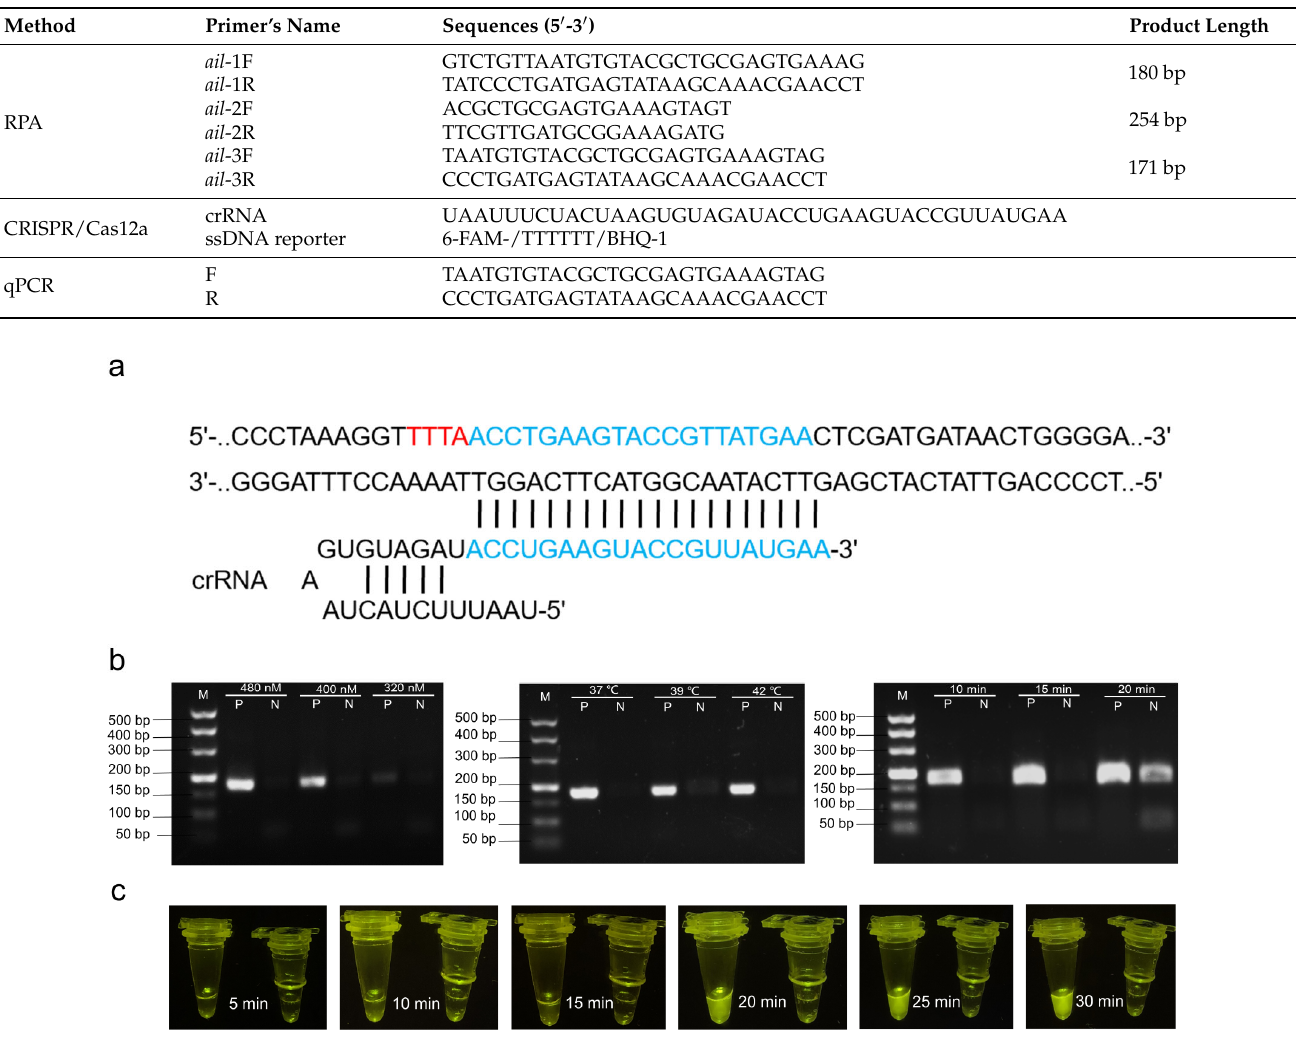
Table 1. Sequences of oligonucleotides used in this study.